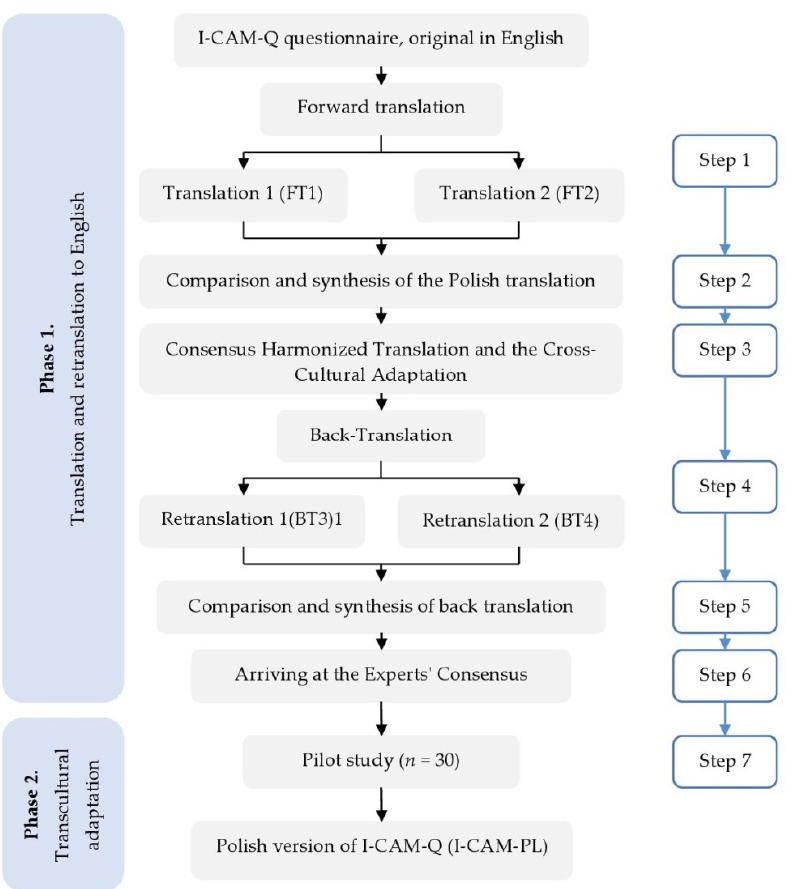
Figure 1. Phases of linguistic validation and the cross-cultural adaptation process of the Polish version of the I-CAM-Q questionnaire.